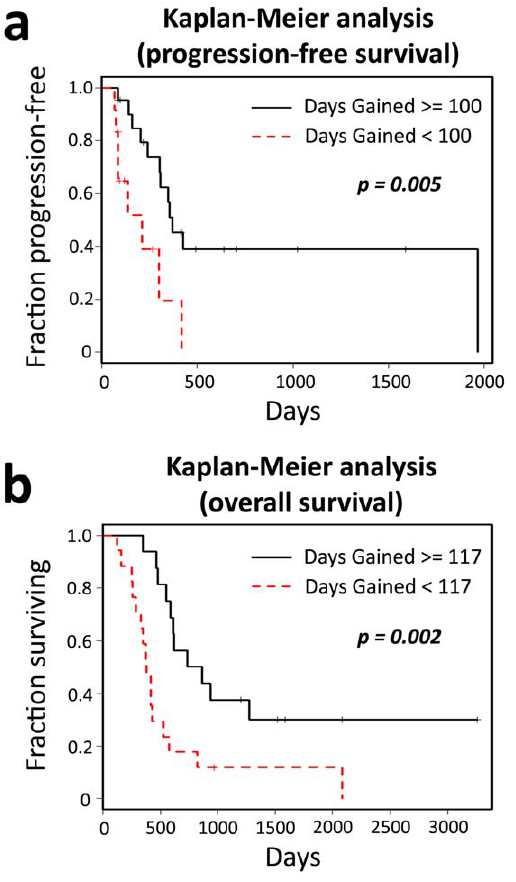
Figure S1 Color map of p-values from iterative Kaplan-Meier analyses on progression-free survival (PFS) and overall survival (OS). White boxes correspond to statistically significant values. The analyses revealed a range of Days Gained thresholds that separate patients into groups with significantly different PFS and OS outcomes. The most significant p-values for PFS and OS were at the 100 and 117 Days Gained thresholds, respectively. (TIF)